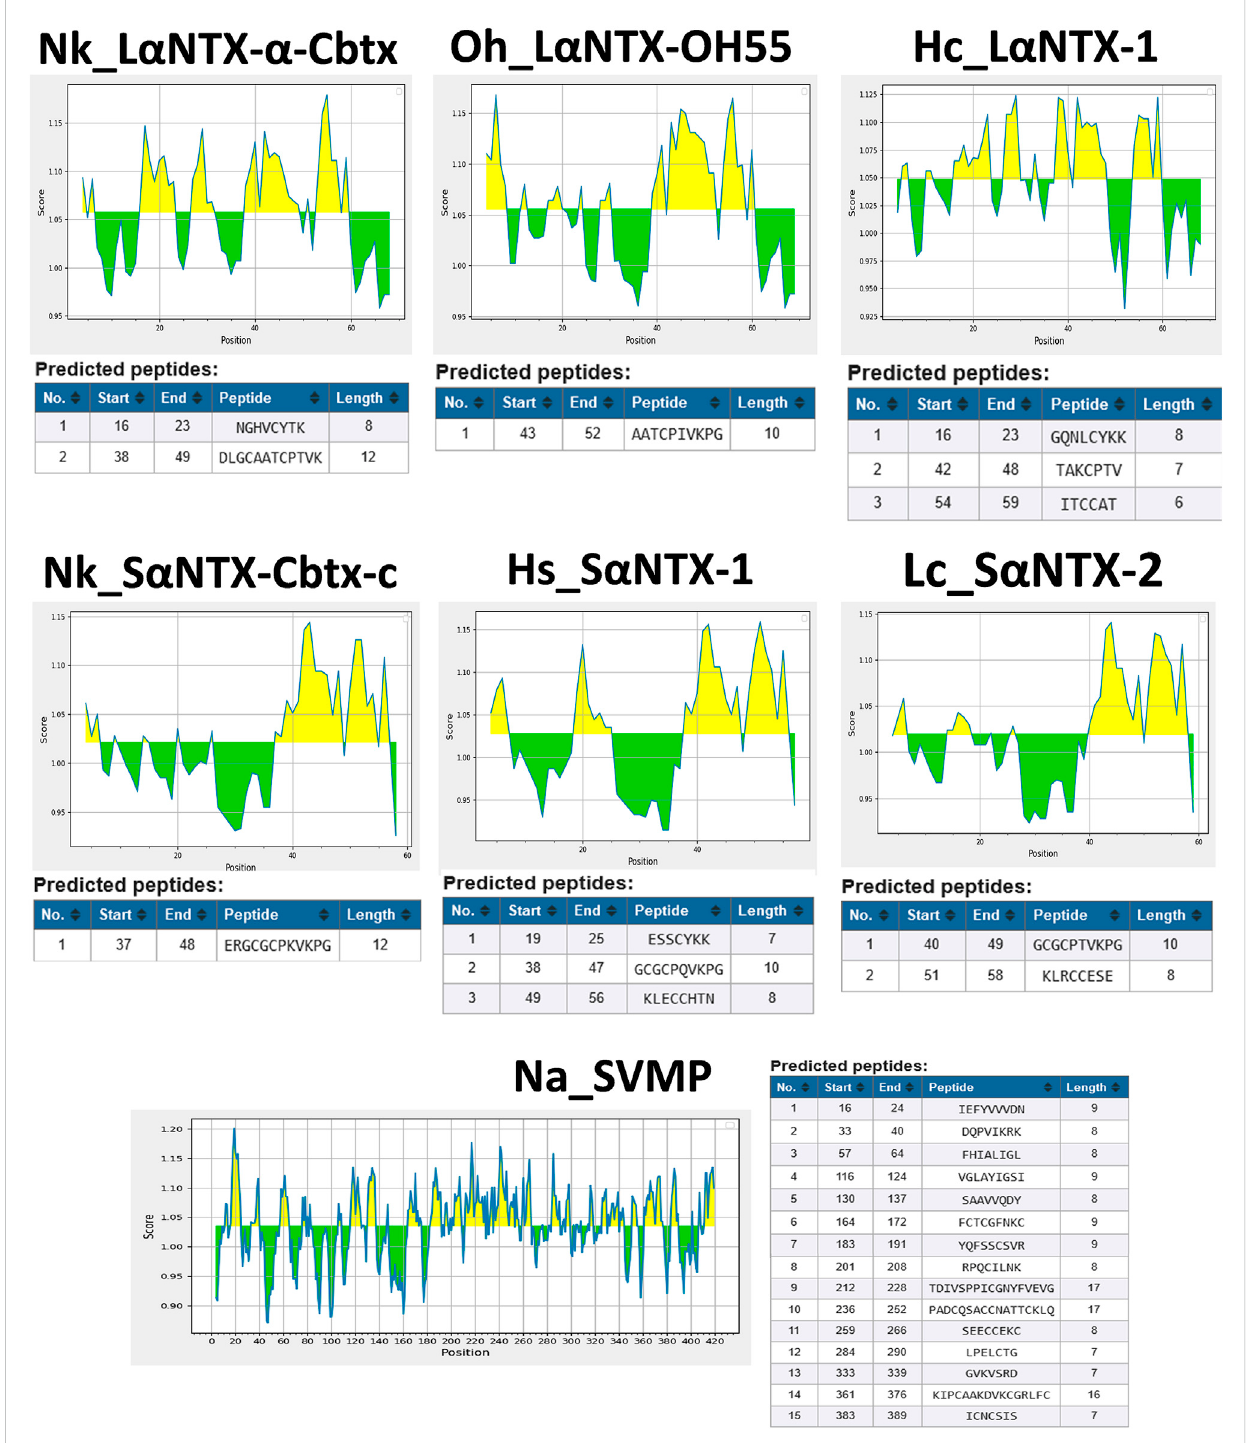
FIGURE 2 Prediction of antigenic determinants (B-cell epitope) of α -NTXs with Kolaskar and Tongaonkar antigenicity scale (Kolaskar and Tongaonkar, 1990). Abbreviations: Nk_L α NTX- α -Cbtx, α -cobratoxin (UniProt ID: P01391, N. kaouthia ); Oh_L α NTX-OH55, long neurotoxin OH55 (UniProt ID: Q53B58, O. hannah );Hc_L α NTX-1,longneurotoxin 1(UniProtID:Q8UW29, H.curtus );Nk_S α NTX-Cbtx-c, cobrotoxin-c(UniProt:P59276, N.kaouthia );Hs_S α NTX- 1,shortneurotoxin1(UniProtID:P68415, H.schistosus );Lc_S α NTX-2,shortneurotoxin2(UniProtID:P10457, L.colubrina );Na_SVMP,snakevenom zinc metalloproteinase (Uniprot ID: D3TTC2, Naja atra ) (high MW toxin). Yellow areas represent predicted B-cell epitopes with antigenicity scores above the dynamic threshold